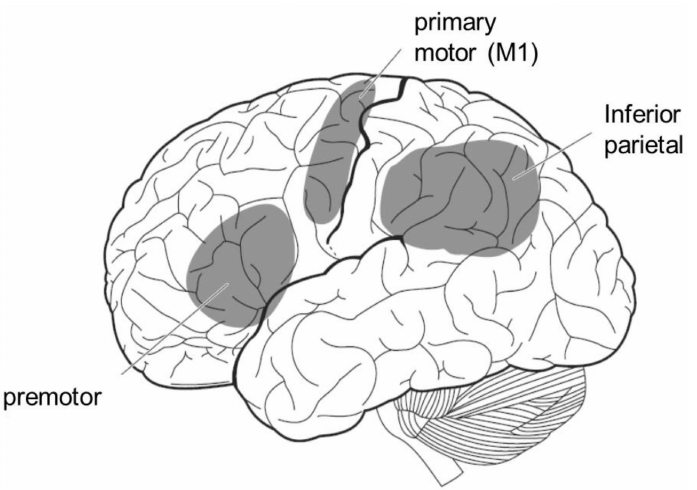
Figure 6. The mirror neuron system. It is activated not only when the individual performs a certain action, but also when he or she observes others performing the same